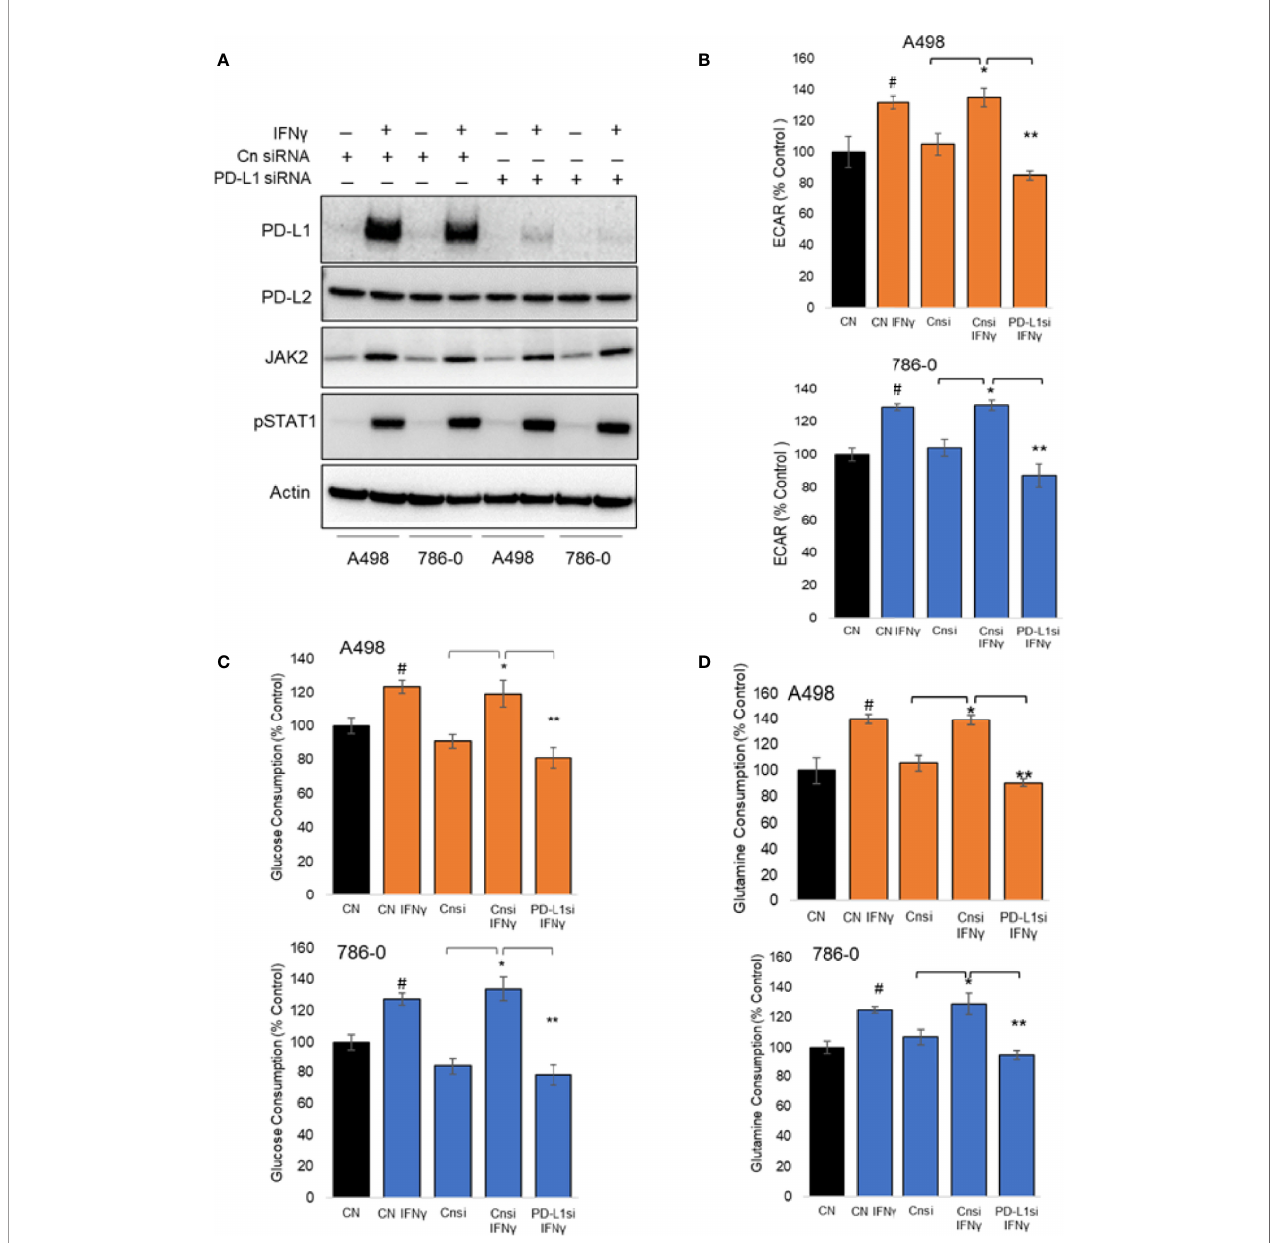
FIGURE 3 | Metabolic effect of transient silencing of inducible expression of PD-L1 in A498 and 786-O cells. (A) 24 hours after silencing of PD-L1 (PD-L1 siRNA) or scrambled siRNA used as controls (Cn siRNA), A498 and 786-O cells were treated with IFN g (50 ng/ml) for 24 hours, n=3. The protein expression of PD-L1, PD-L2, JAK2, STAT1 and the phosphorylation of STAT1 was then assessed by immunoblotting. (B) the metabolic effect of PD-L1 silencing was assessed using a bioanalyzer in IFN g treated and PD-L1 silenced A498 and 786-O cells. A498 and 786-O cells without IFN g treatment are used as controls. ECAR and OCR data are presented as mean ± SD (n=3) *p<0.05, **p<0.001. (C, D) A decrease in glucose and glutamine consumption was observed in PD-L1 silenced (PD-L1si IFN g ) A498 and 786-O cells as compared to IFN g treated (Cnsi IFN g ) treated cells. The data are presented as mean ± SD (n=3) *p<0.05, **p<0.001, # p<0.05 for CN IFN g compared to